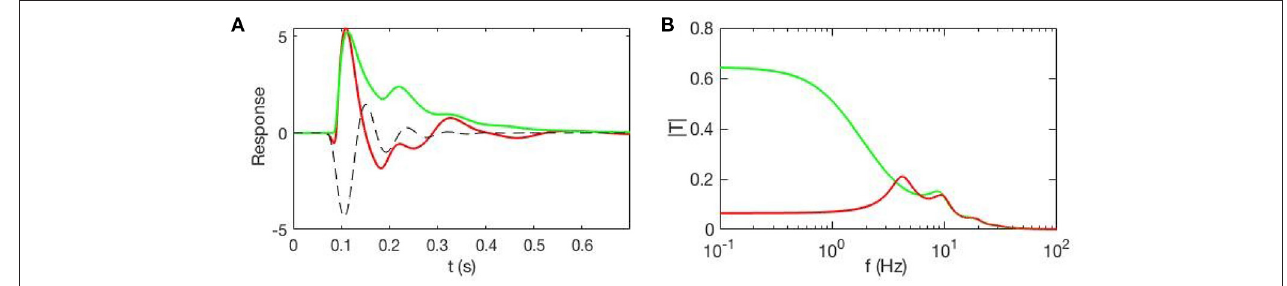
FIGURE 4 | Evoked responses and transfer functions for cases with static EC (green) and dynamic EC (red) starting from the same initial state. (A) Model cortical evoked responses. The dashed black line shows the contribution of the EC dynamics and adds to the green curve to give the red one. (B) Magnitudes of the corresponding transfer